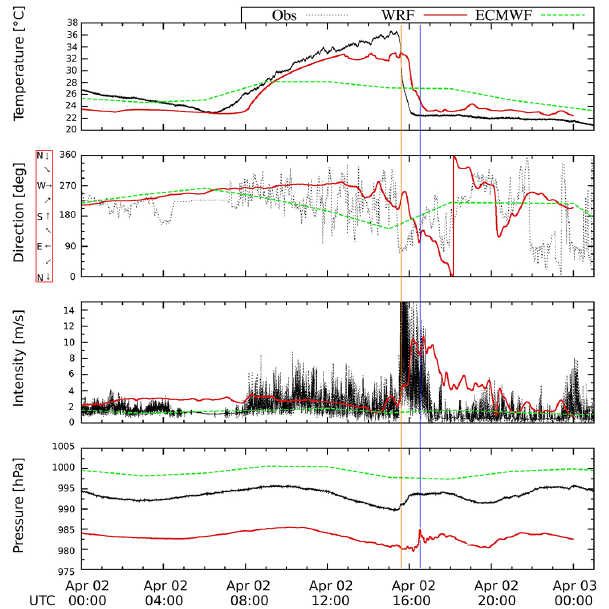
Fig. 7. Real simulation (red line), in situ observation of meteorolog- ical station IS17 (black dots) and ECMWF reanalysis data (dashed green line). Surface time records of temperature [ ◦ C], wind direc- tion [degrees], wind intensity [ms − 1 ] and total pressure [hPa], plot- ted as a function of time (UTC), on 2 April